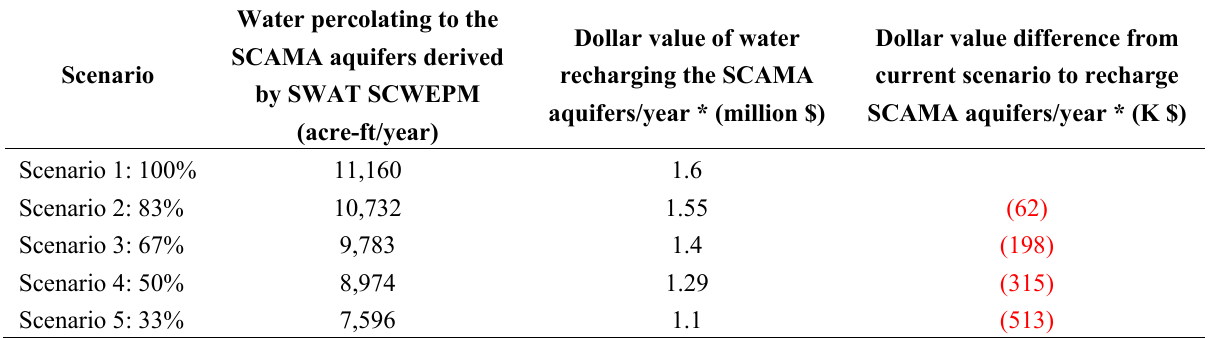
Table 3. Dollar value, based on calendar year 2013 ( * ), of binational effluent percolating the soil—estimated as recharge to the aquifer—in the Santa Cruz Active Management Area (SCAMA), where $144 is paid per acre-foot of water (325,851 gallons). SWAT, Soil and Water Assessment